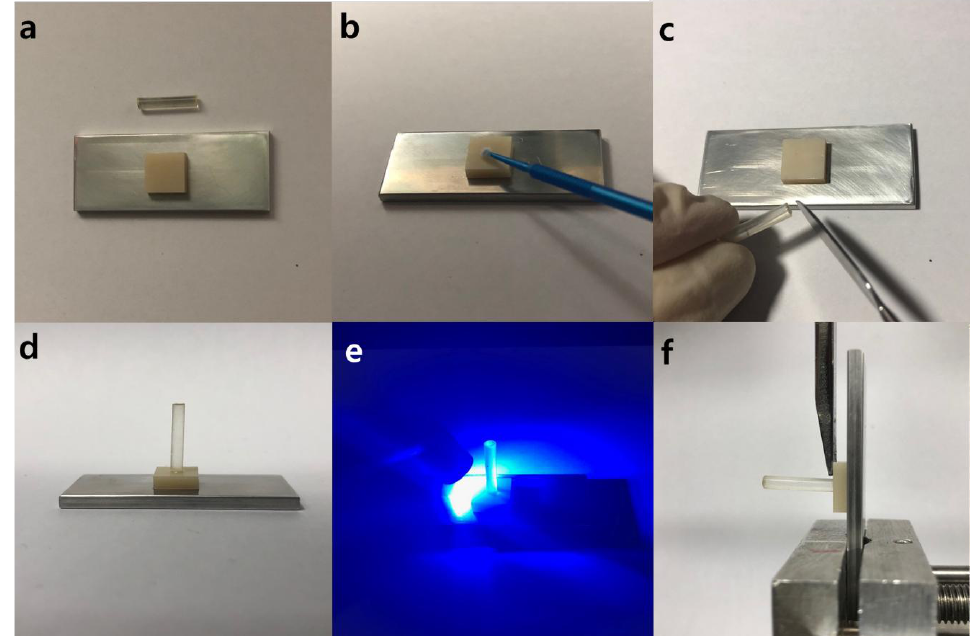
Figure 2. Images taken during sample preparation: ( a ) a zirconia sample adhered to a stainless-steel plate; ( b ) apply primer solutions on the zirconia surface; ( c ) dental resin cement applied to the bottom of resin rod; ( d ) the resin rod placed on the surface; ( e ) light curing; ( f ) knife-edge shear bond test.